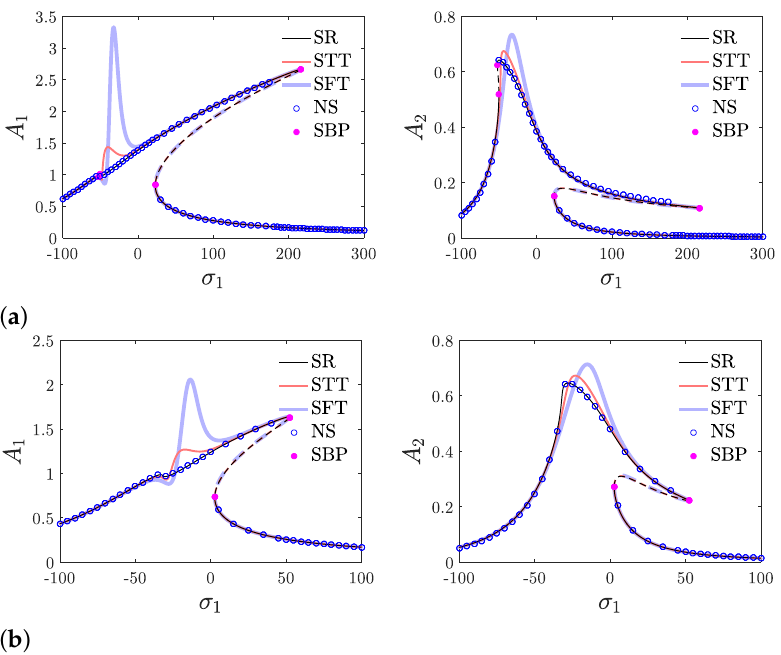
Figure 6. Comparisons between the solutions based on the residue theorem and Taylor expansion; ( a ) E X = 40 and E Y = 30 and ( b ) E X = 25, and E Y = 20. SR: solutions based on the residue theorem, STT: solutions based on the third-order Taylor expansion, SFT: solutions based on the fifth-order Taylor expansion, NS: numerical solutions, SBP: the saddle-node bifurcation